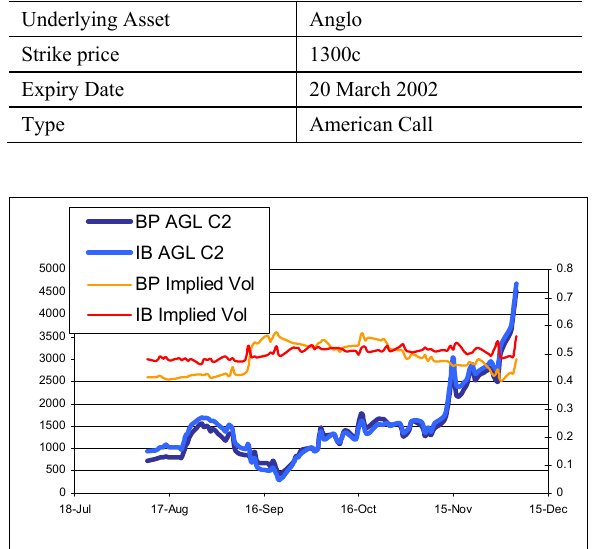
Figure 2: Anglo: BP vs IB Warrants